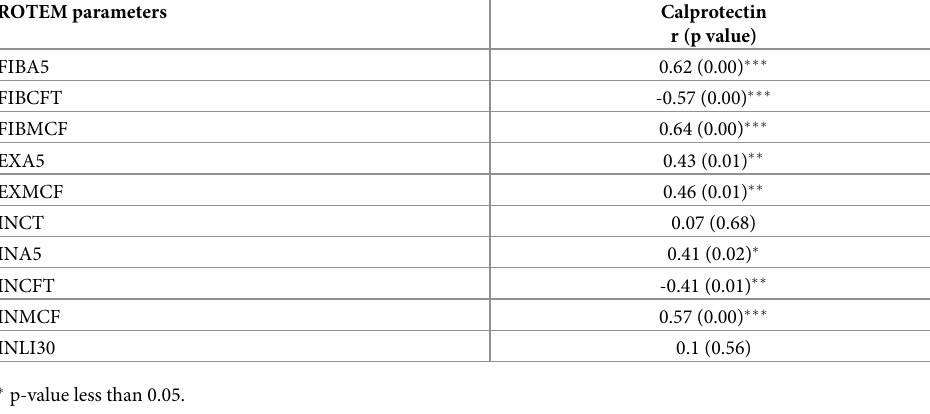
Table 3. Spearman rank correlations between ROTEM and coagulation and